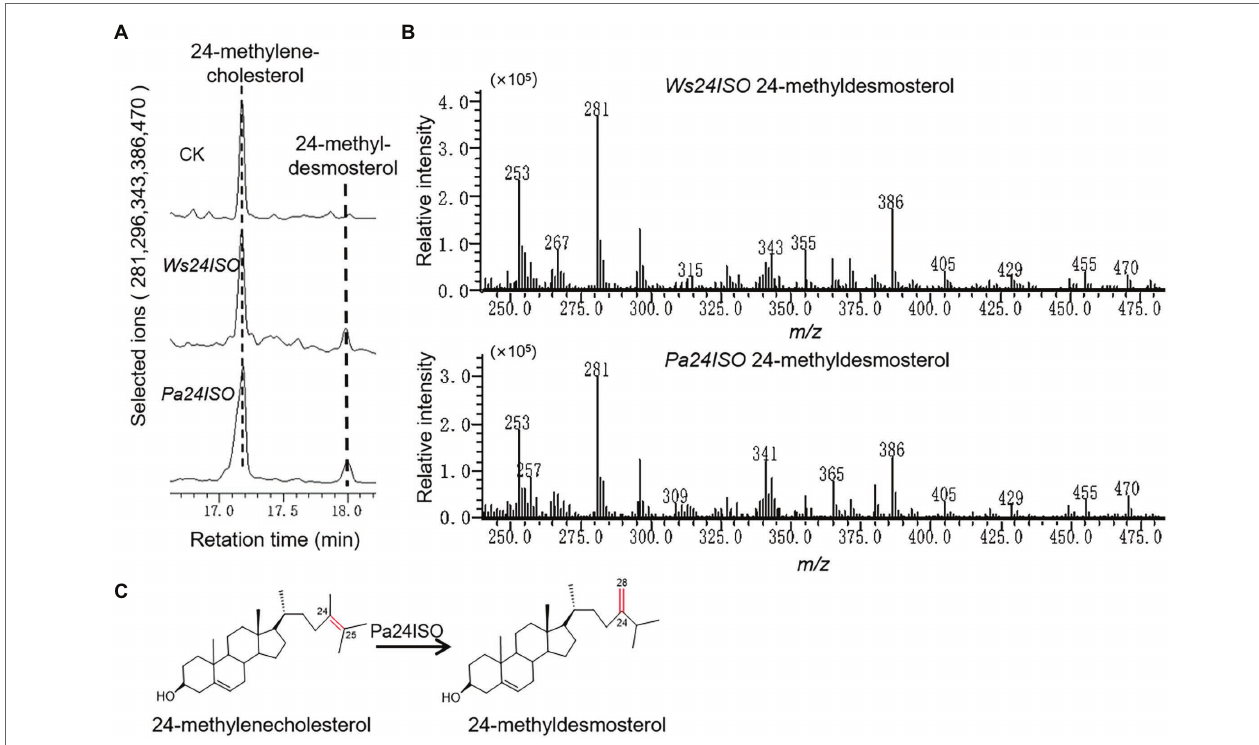
FIGURE 3 | Enzymatic characterization of Pa24ISO in a 24-methylenecholesterol-producing yeast. (A) GC–MS chromatograms of yeast extracts from the yeast strain YS11 expressing Pa24ISO , Ws24ISO or empty vector. The 24-methyldesmosterol product was detected in the cells expressing Pa24ISO or Ws24ISO but not in the cells harboring the empty vector. (B) Mass spectra of the 24-methyldesmosterol product formed by Pa24ISO or Ws24ISO. (C) The reaction scheme showing the activity of Pa24ISO in converting 24-methylenecholesterol to